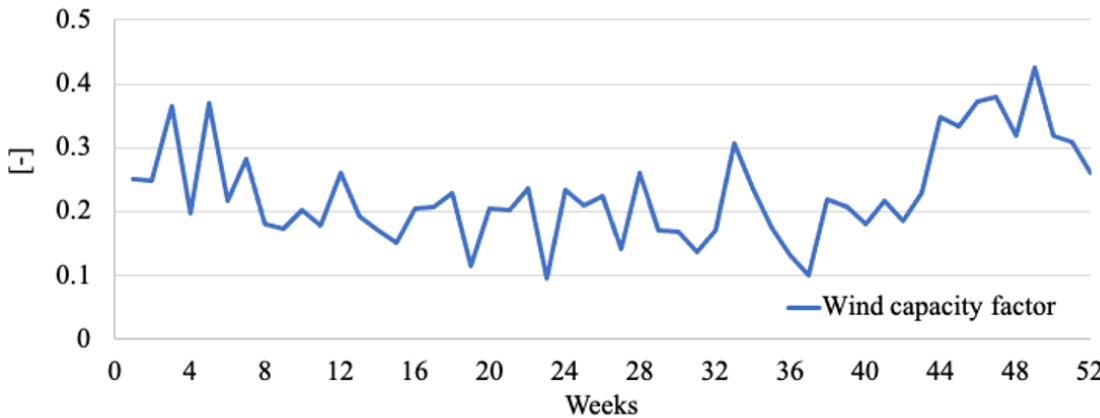
Figure 8. The capacity factor of wind generation in Hokkaido 2019.